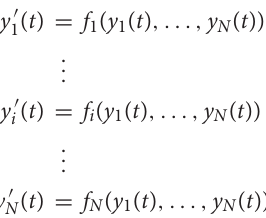
FIGURE 1 | Artefactual shift when using the single-step method. The black curve shows the reference time course of the membrane potential of a Hodgkin-Huxley point-neuron model subject to a constant input current of 200 pA after simulating 1 s of biological time. The other curves indicate the time course of the membrane potential of the same neuron with the same input for the case that the neuron is coupled by a gap junction to a second model neuron with exactly the same properties and the simulation is carried out with the single-step approach using a Runge-Kutta-Fehlberg solver with an adaptive step-size control to cover the interval of one computation time step h . The orange curve displays the result for a step size of h = 0 . 1 ms and the blue curve for 0 . 02